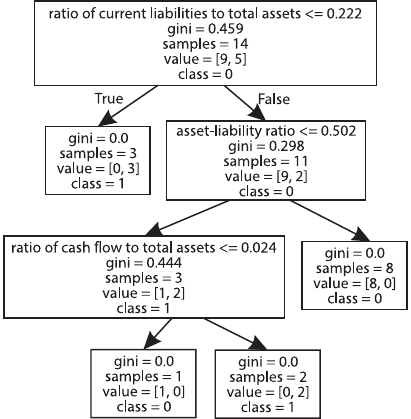
Figure 2. Financial indicator selection by CART decision tree